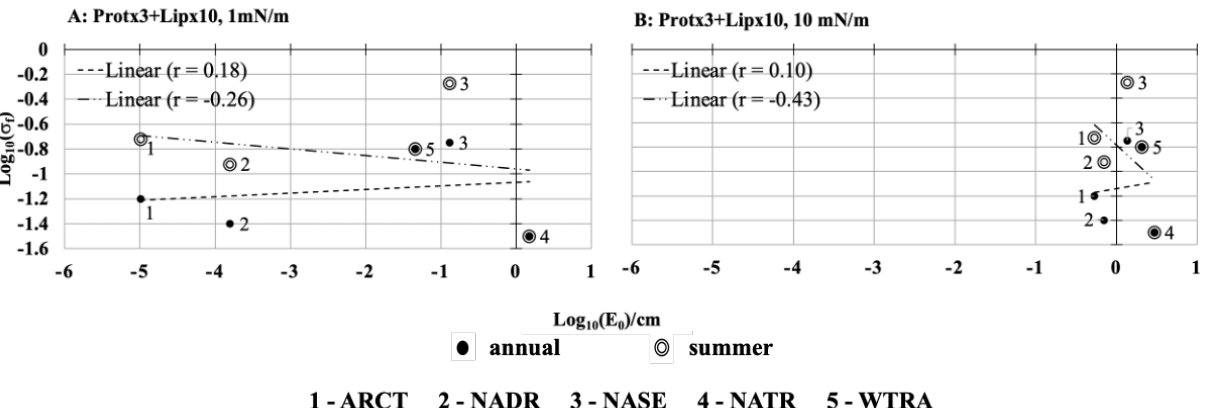
Figure 4. Annual ( ) and summer ( ) log Sigma-0 frequency vs. the log of capillary wave height when the protein (Prot) and lipid (Lip) concentrations are scaled by varying amounts. ( A ) no sur- factants ( B ) baseline protein ×3 but no lipids, ( C ) baseline protein ×3 and baseline lipid ×10, ( D ) baseline protein ×3 and baseline lipid ×100, ( E ) baseline protein ×10 and baseline lipid ×10, ( F ) base- line protein ×10 and baseline lipid ×100. All computations were performed at the surface pressure threshold value of 3 mNm − 1 .